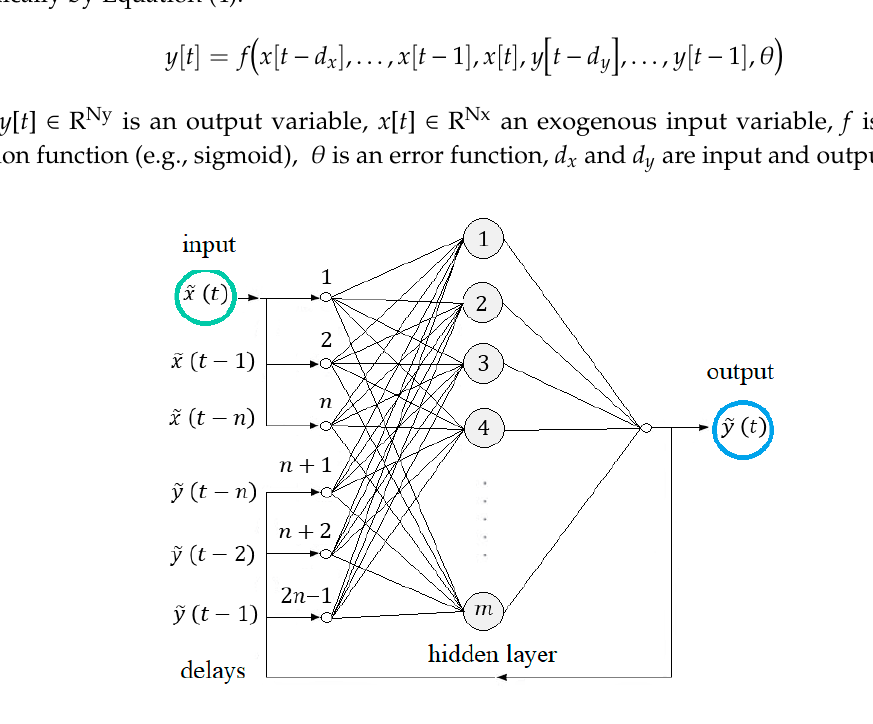
Figure 2. Example of a feed-forward ANN: ( a ) neuron, ( b ) architecture.